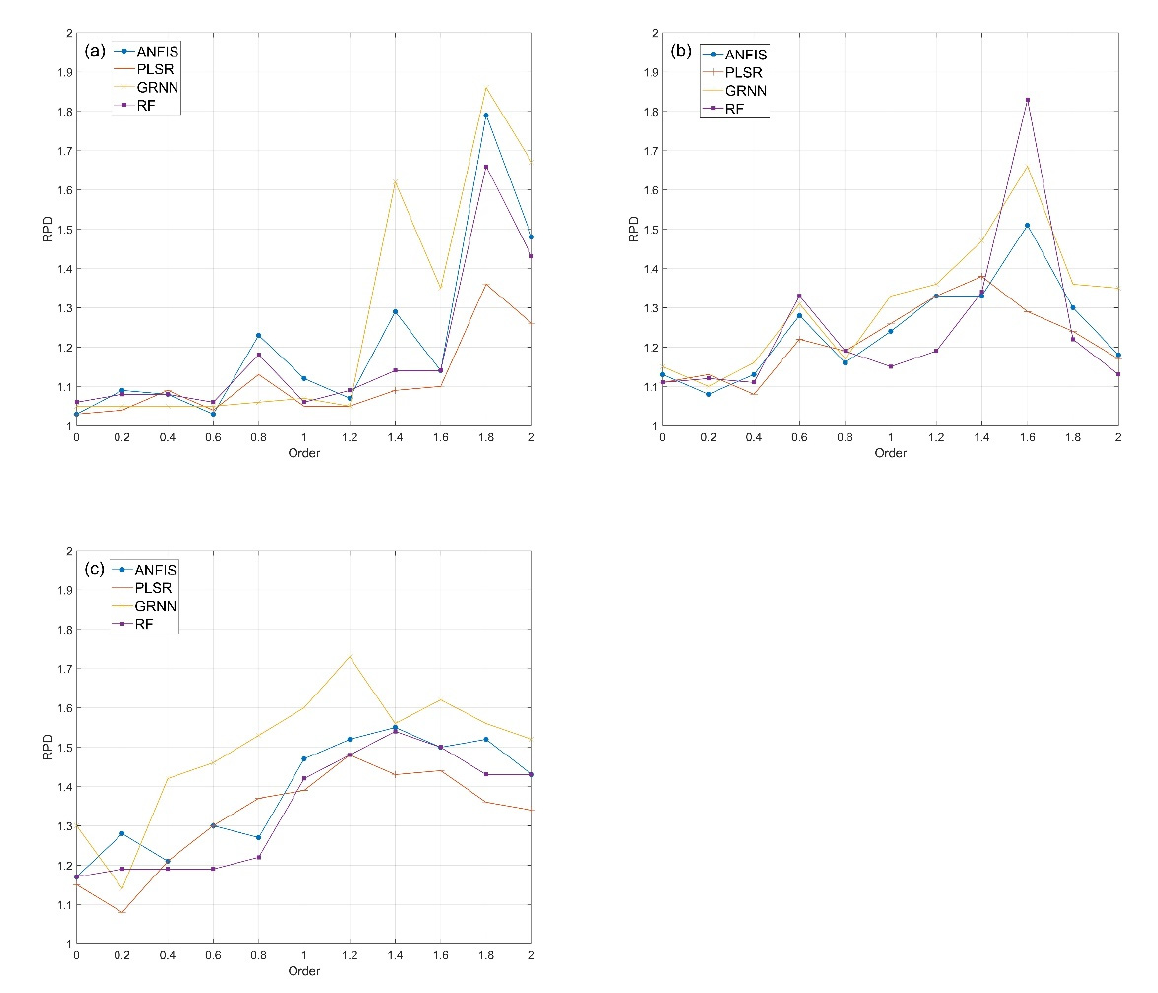
Figure 3. Line charts of RPD versus heavy metal concentration estimation results using fractional-order derivatives of ( a ) Hg, ( b ) Cr, ( c ) Cu.